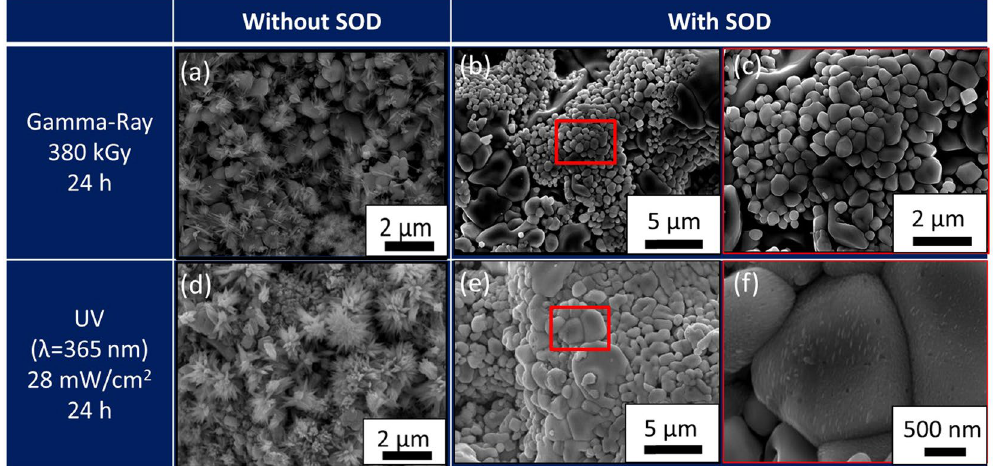
Figure 9. SOD addition test. FE-SEM images of the surface after irradiation of ( a ) 24 hours at 380 kGy gamma- rays without SOD in ultrapure water. ( b ) 380 kGy gamma-rays irradiation with SOD in ultrapure water. ( c ) Enlarged view of rectangle area in ( b ). ( d ) UV irradiation for 24 hours. ( e ) UV irradiation for 24 hours with the addition of SOD. ( f ) Enlarged view of rectangle in ( e